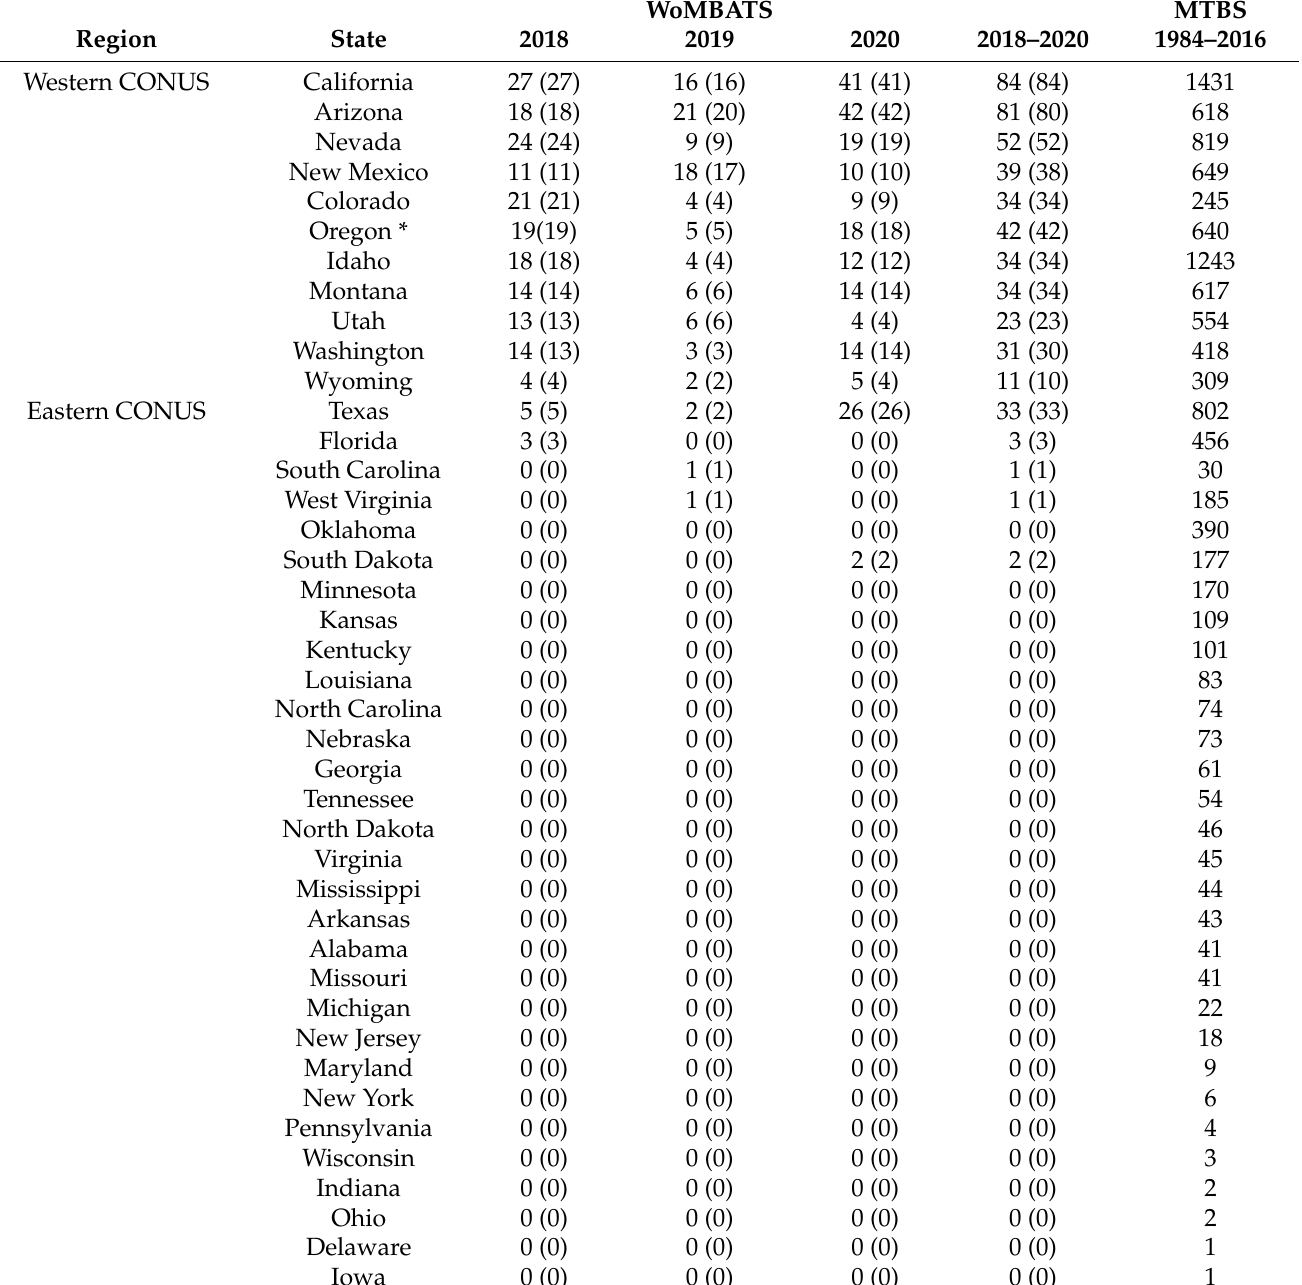
Table 4. Number of wildfires from two WoMBATS and MTBS, dis-aggregated by state and year. The number of large (>405 ha) wildfires are reported in the parenthesis. States divided into West- ern Continental United States (CONUS), Eastern CONUS, and Outside CONUS. The asterisk * denotes that two long-duration wildfires that ignited in 2017 are included in Oregon 2018 WoMBATS fire